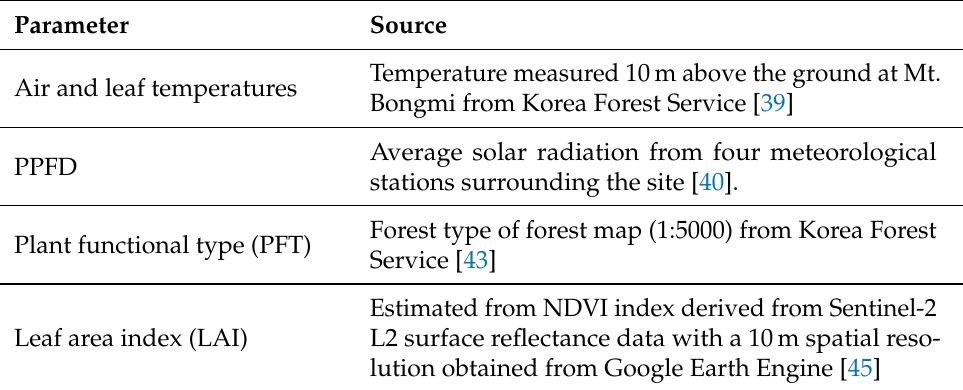
Table 3. List of input parameters and their sources for the MEGAN model of the study site.